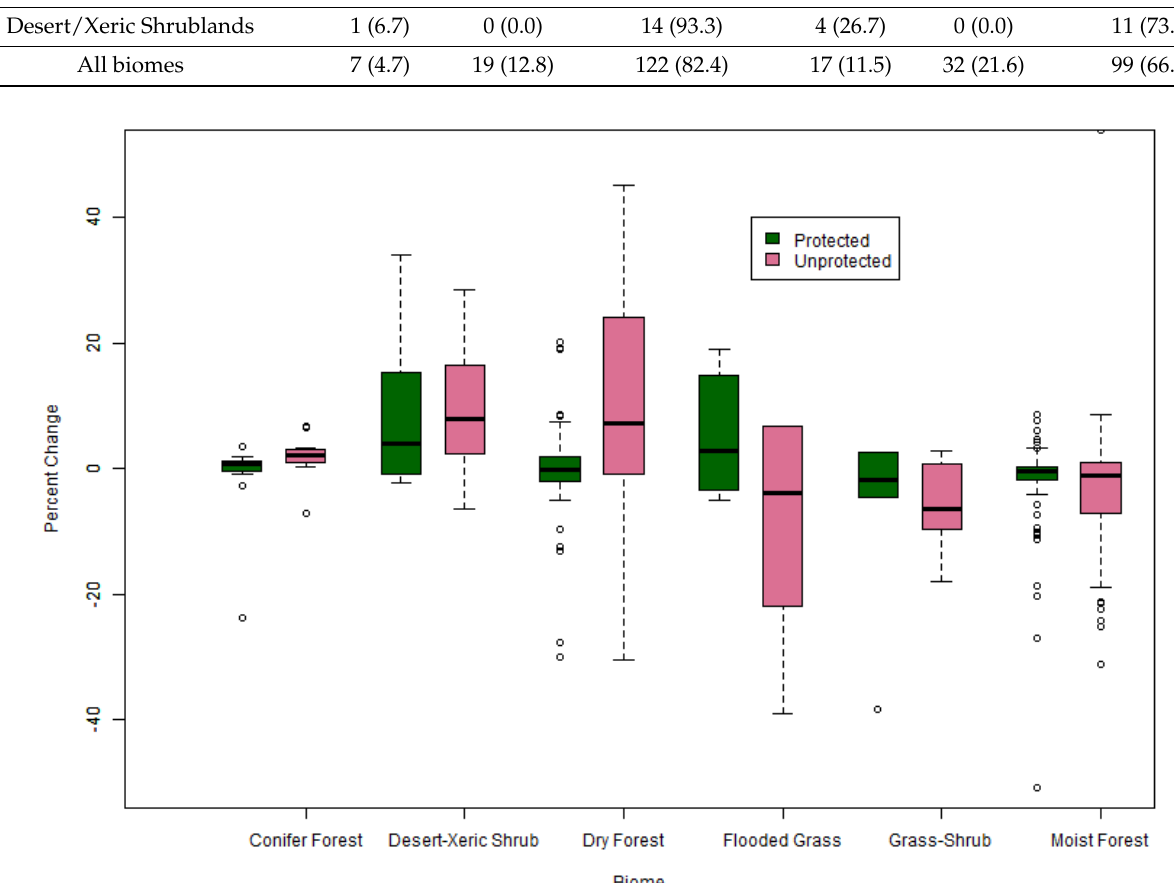
Figure 6. Percent woody change within and outside of protected areas for ecoregions within biomes.